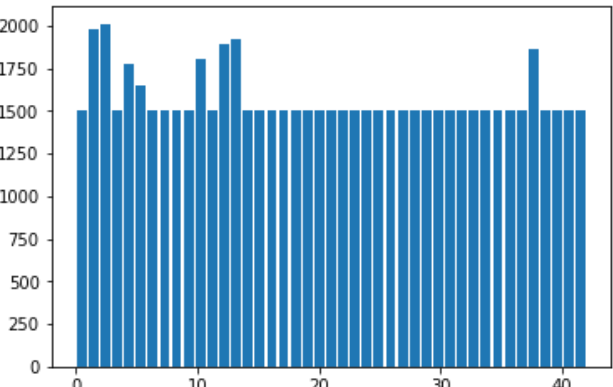
Figure 9. The number of 43 classes of traffic signs after generating the artificial dataset.